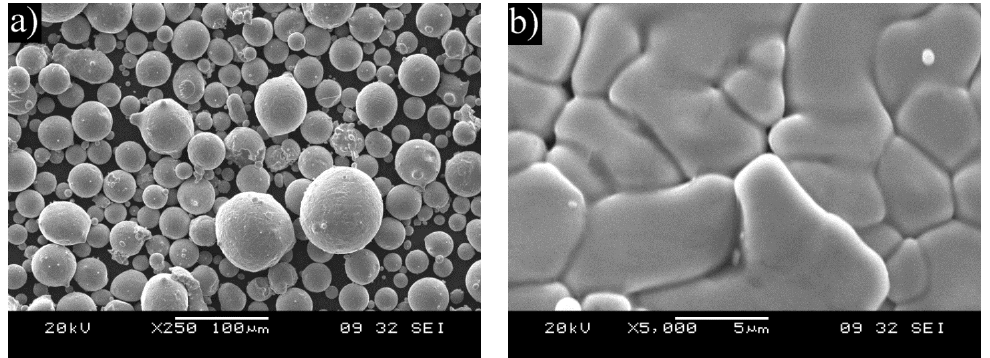
Figure 4. SEM images of gas atomized FeNiCrAl powder sieved below 45 μm, magnifications with micron bars. ( a ) 100 μm; ( b ) 5 μm.